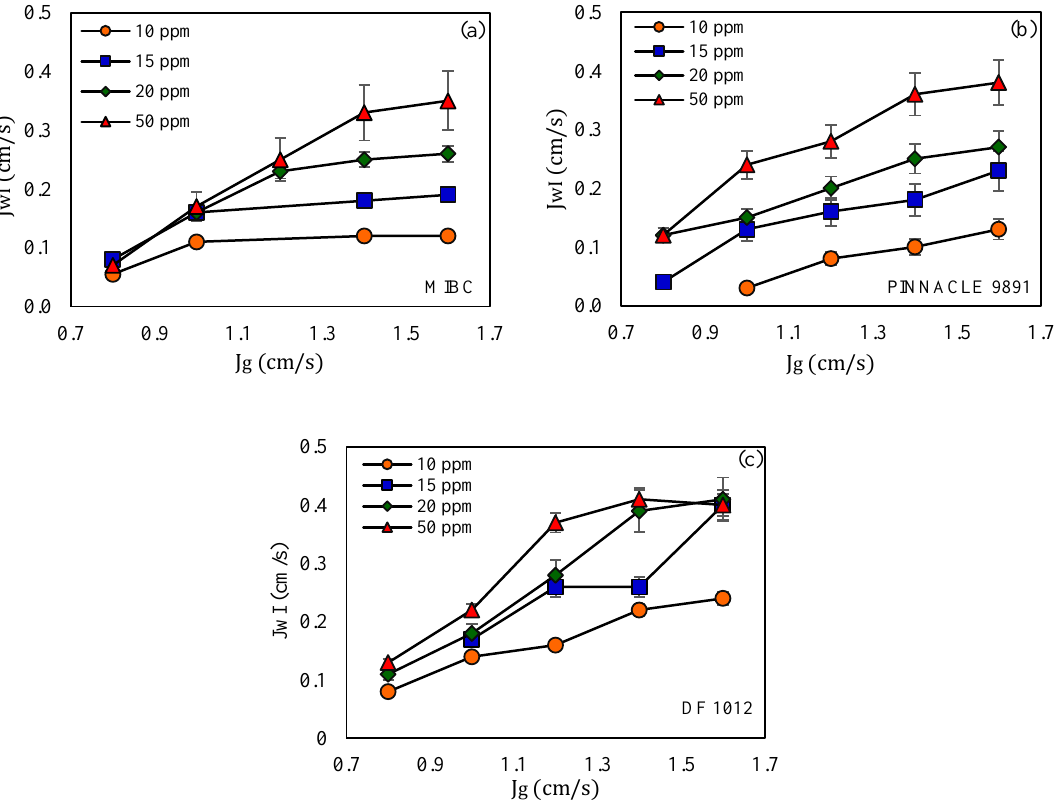
Figure 2. Water rate into the froth as a function of gas rate and frother concentration for ( a ) MIBC, ( b ) PINNACLE 9891 and ( c ) DF 1012.